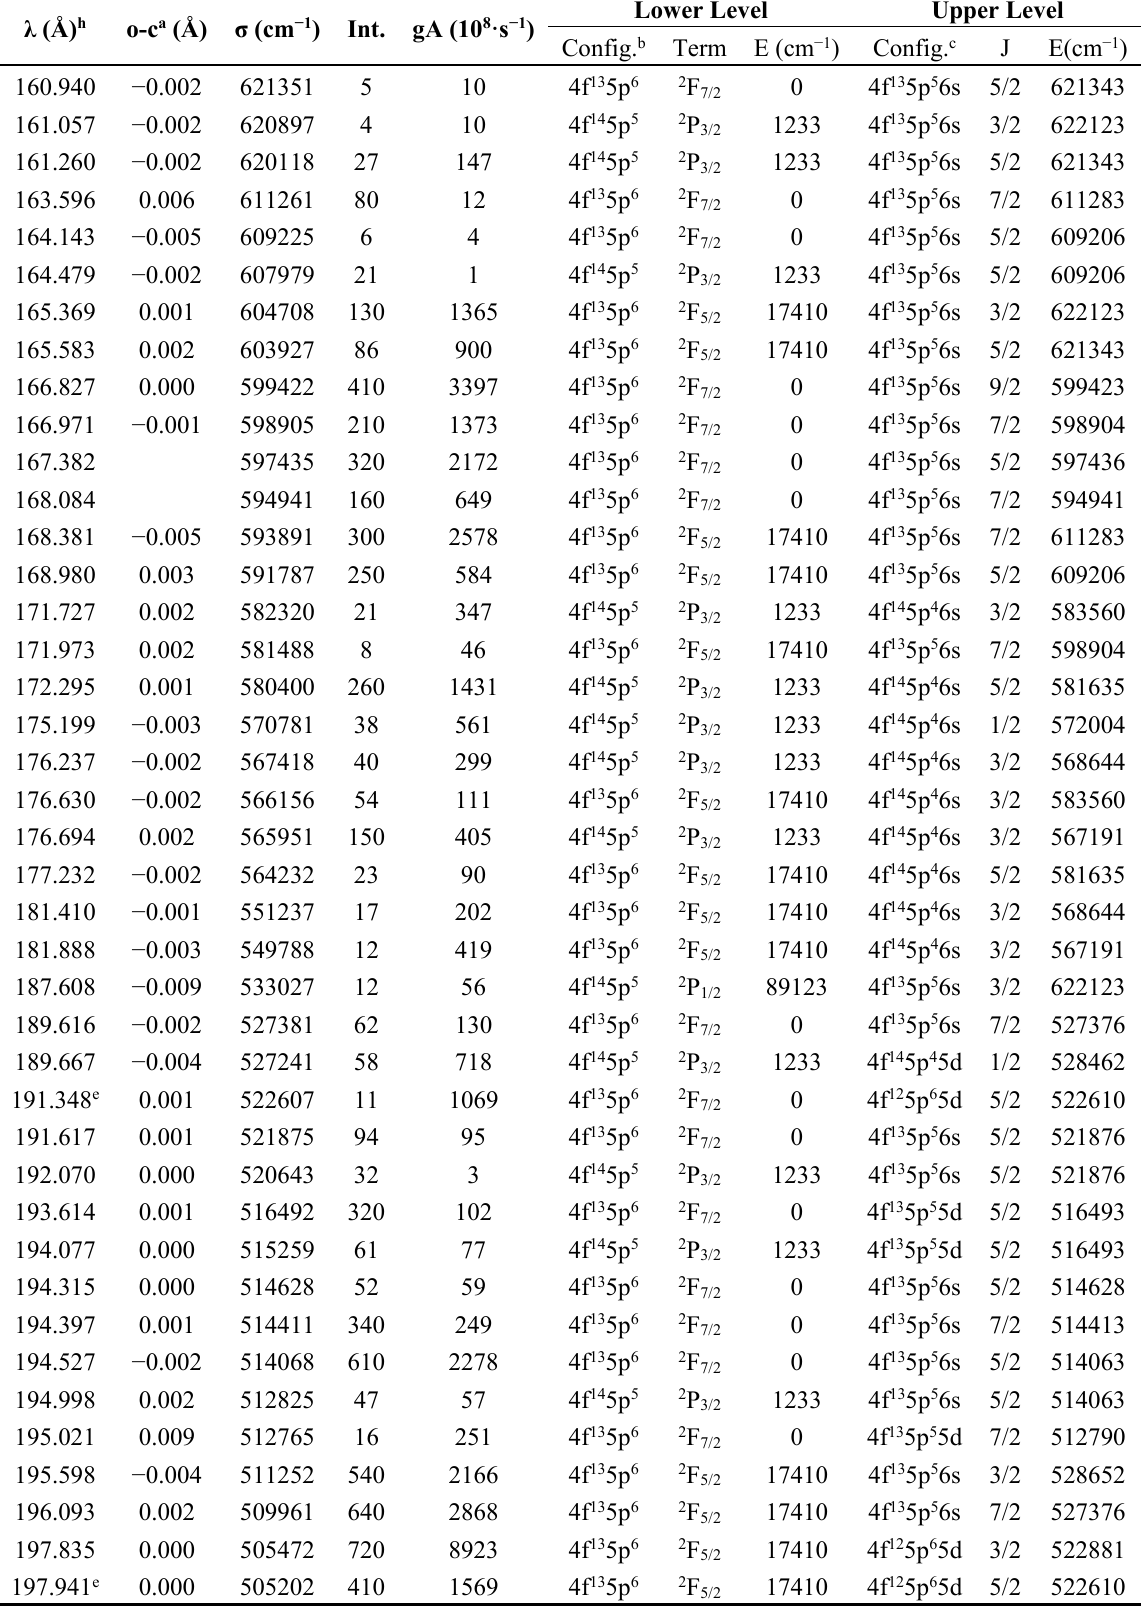
Table 1. Identified lines in the spectrum of W